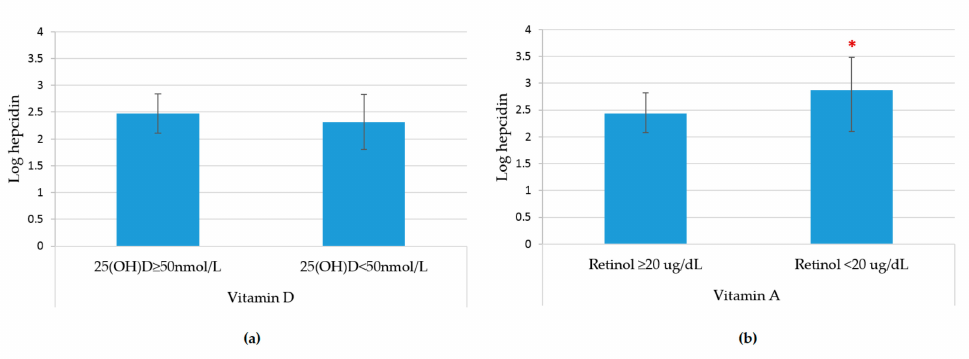
Figure 1. Logarithmic normalized hepcidin levels by vitamin D and vitamin A status, adjusted by age, sex and status of inflammation (CRP and AGP) in Mexican older adults. ( a ) Mean of log-hepcidin by vitamin D deficiency; and ( b ) mean of log hepcidin by vitamin A deficiency. * p <